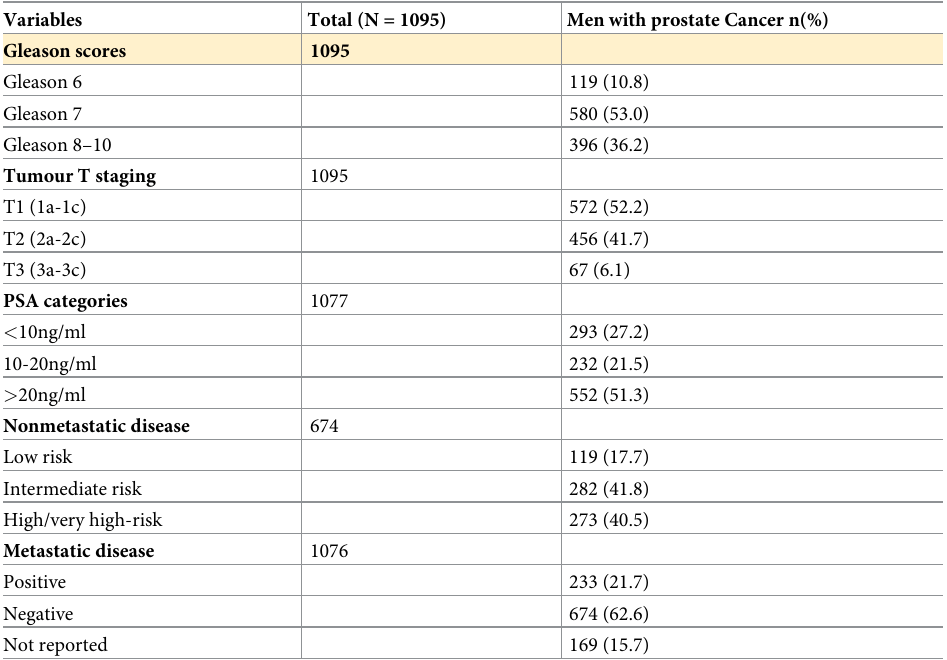
Table 3. Clinical characteristics of men with prostate cancer.